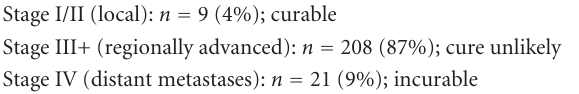
Table 2: Bangladesh hormone receptor test results pre- and post- tissue processing protocol